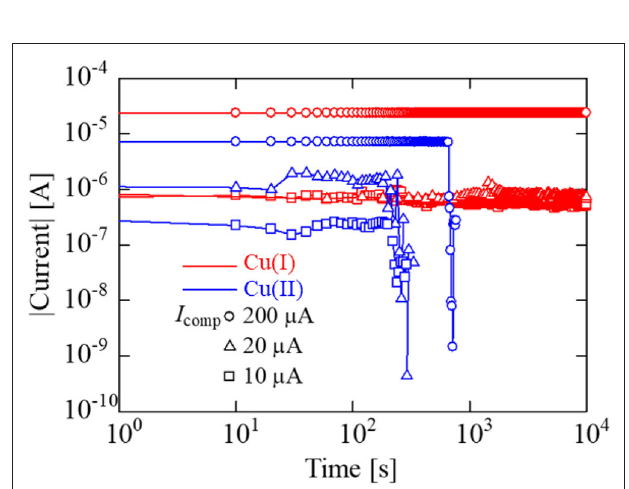
FIGURE 9 | Data retention characteristics of Cu(I)-IL-Memristor (red) and Cu(II)-IL-Memristor (blue). For both devices, I comp was set at 10, 20, and 200 µ A. The Cu(II)-IL-Memristor showed a short data retention time ( < 10 3 s), whereas the Cu(I)-IL-Memristor showed a relatively long data retention time (more than 10 4